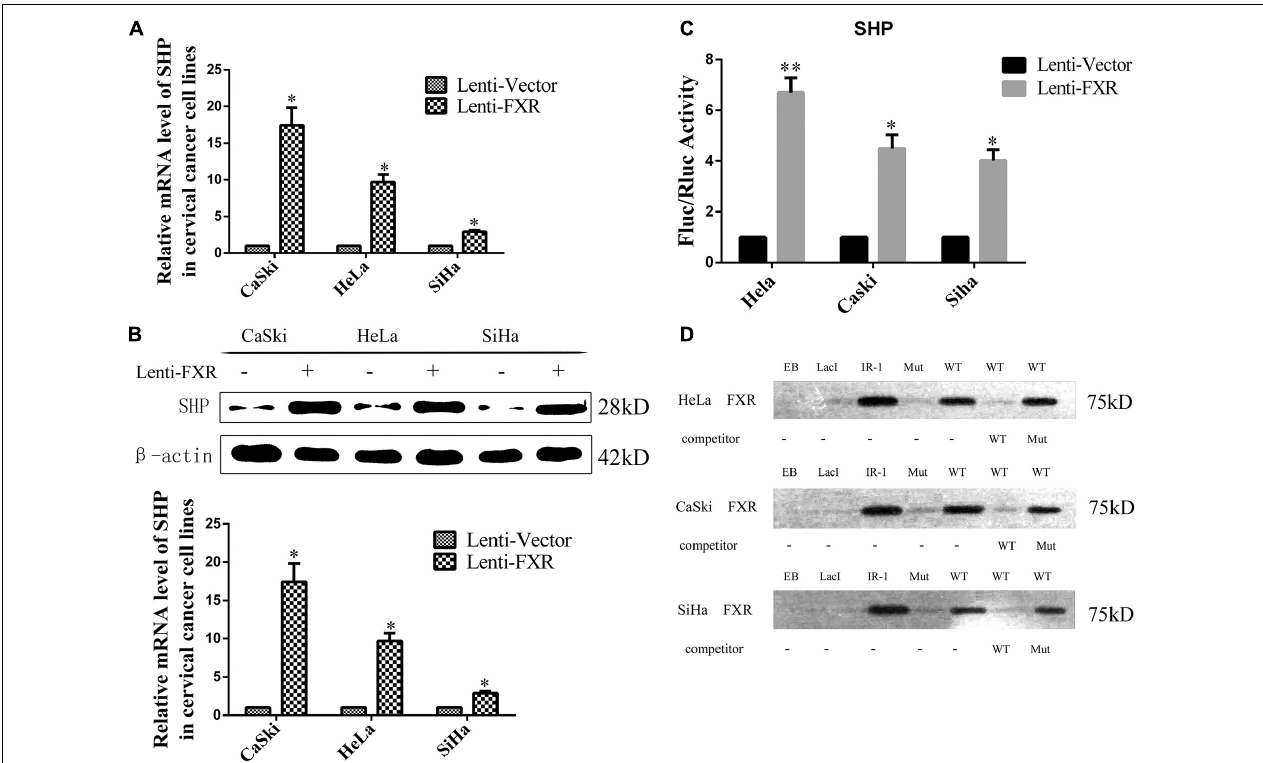
FIGURE 4 | FXR regulates SHP expression through direct binding to the LRH-1 promoter element. Overexpression of FXR increased SHP mRNA (A) and protein (B) levels. The dual-luciferase activity was measured in the Lenti-Vector or Lenti-FXR transfected cells, the following co-transfection with a SHP promoter reporter vector and a plasmid expressing Renilla luciferase. Fold change was expressed with Renilla luciferase as an internal control (C) . A SHP-122/-69 DNA probe binding FXR in DNA pull-down assay (D) . ∗ P < 0.05, ∗∗ P < 0.01 vs. Lenti-Vector